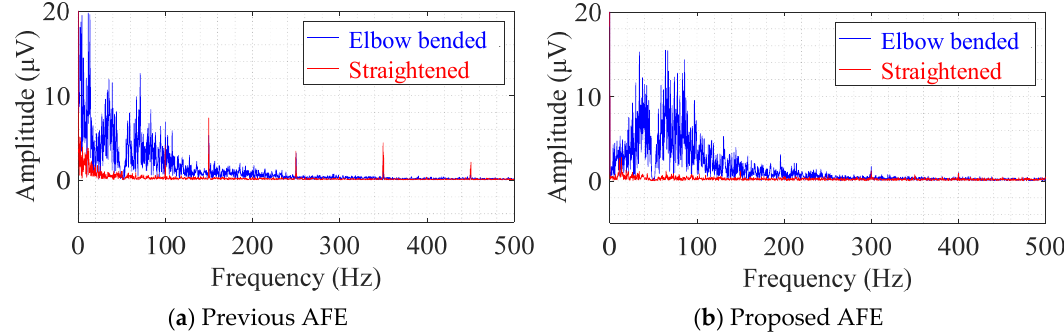
Figure 10. Digital Fourier transform (DFT) spectra for cEMG recordings in Figure 9 obtained from subject #E using ( a ) the previous AFE and ( b ) the proposed AFE. The blue line corresponds to the spectra for “Elbow bended” segments, and the red line corresponds to that for “Elbow straightened” segments.